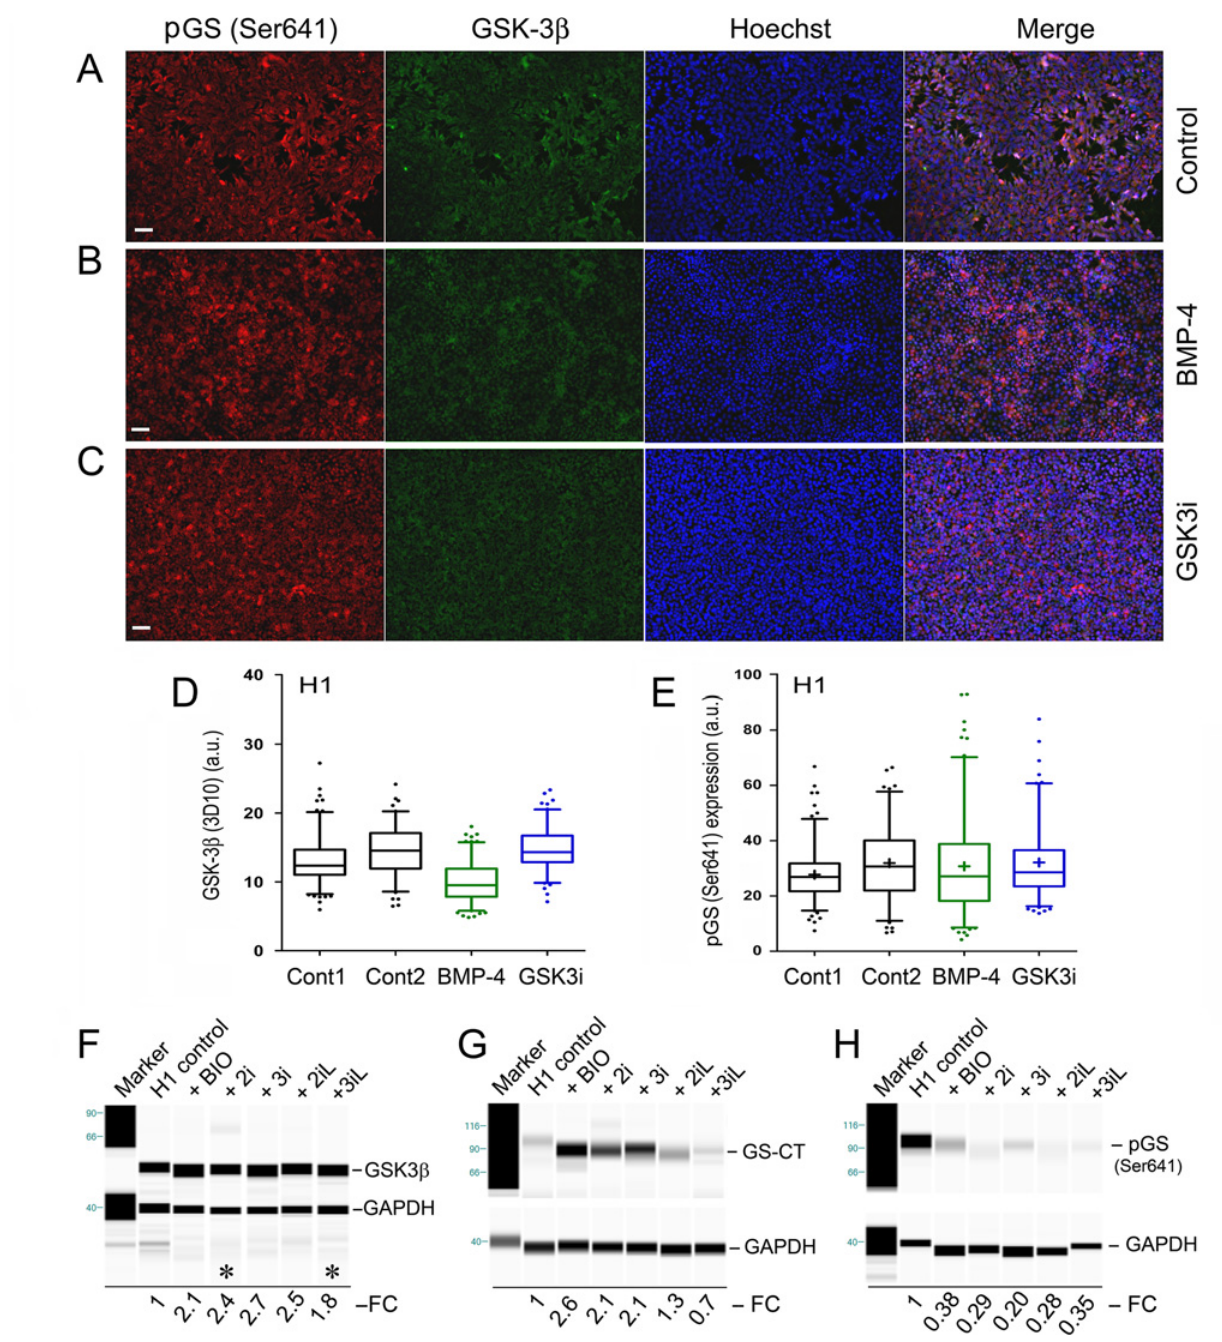
Fig 8. Immunofluorescence analysis of coexpression of the phospho-glycogen synthase (pGS-Ser641) and GSK-3 β in hPSCs. Coexpression of pGS-Ser641 and GSK-3 β in H1 control cells ( A ), H1 cells treated with 100 ng/mL of BMP-4 ( B ), and 3 μ M GSK3i (CHIR99021) ( C ) for 48 hours. The cellular genomic DNAs were stained by the Hoechst 33342 dye (Hoechst). The images were collected with a fluorescence microscope (Zeiss). ( D and E ) Box-and- Whisker plots (with 5 – 95% percentile) of H1 cells under the indicated treatments: Control 2 (i.e., Cont 2) in both D and E is an additionally untreated control of H1 cells. The plus signs (+) in the plots indicate the location of mean values determined from 116 to 150 individual cells by the ImageJ program. One of two independent experiments is shown. Scale bars in the images represent 50 μ m. ( F-H ) Simple Western experiments: H1 Oct4-EGFP (abbreviated as H1) cells were cultured under the monolayer culture condition for 2 passages and treated with na ï ve growth conditions as indicated for 48 hours. Simple Western was carried out in H1 Oct4-EGFP cell lysates using specific antibodies against GSK-3 β , glycogen synthase (C-terminal), and phospho-glycogen synthase at Ser641 (pGS-Ser641). Protein expression was normalized to GAPDH protein control run in the same capillary (lane). Fold changes (FC) of protein expression related to untreated controls were labeled beneath each lane. The lanes marked by asterisk signs (in Fig 8F) were the results obtained from a separate